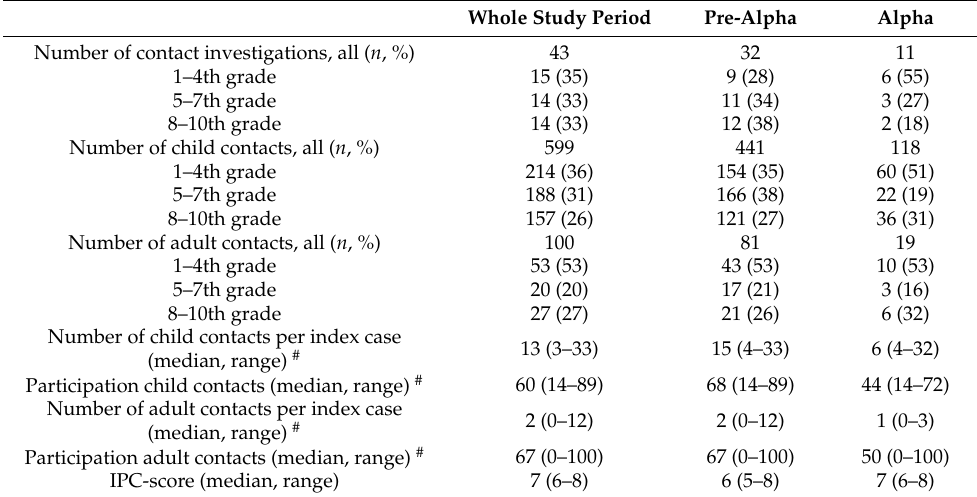
Table 1. Characteristics of the study population in 43 contact investigations in Oslo and